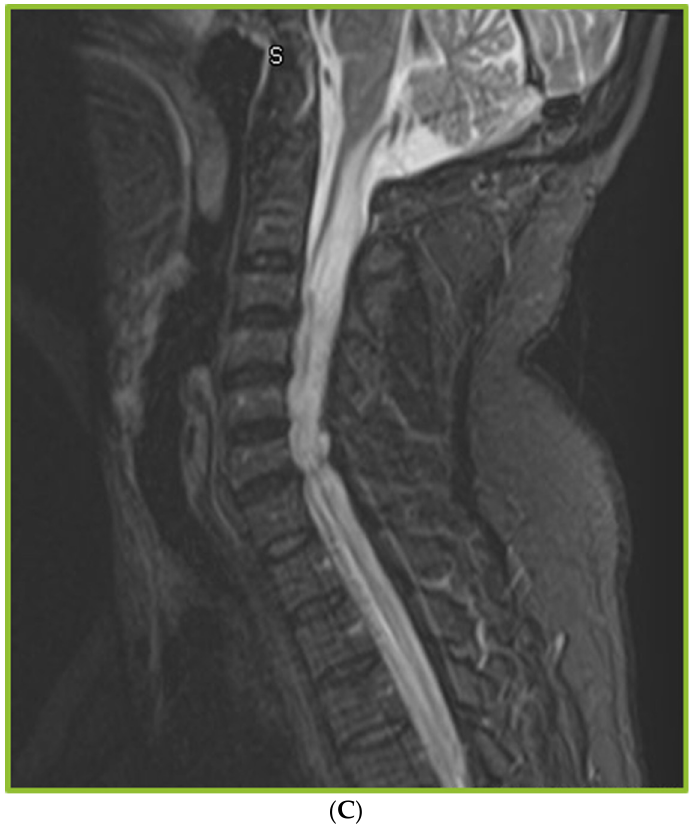
Figure 2. ( A ) Sagittal thoracic MRI spine: Septations, ill-defined irregularity in the intrathecal space, deformity of the thoracic cord, complex ill-defined CSF collections. ( B ) Sagittal post contrast MRI cervical spine: Extensive multilocular fluid tracking from the cervical medullary junction to C5 level with marginal rim enhancement. ( C ) Sagittal cervical and thoracic MRI spine: Extensive syringohydromyelia present throughout the entire cervical cord and upper thoracic cord.